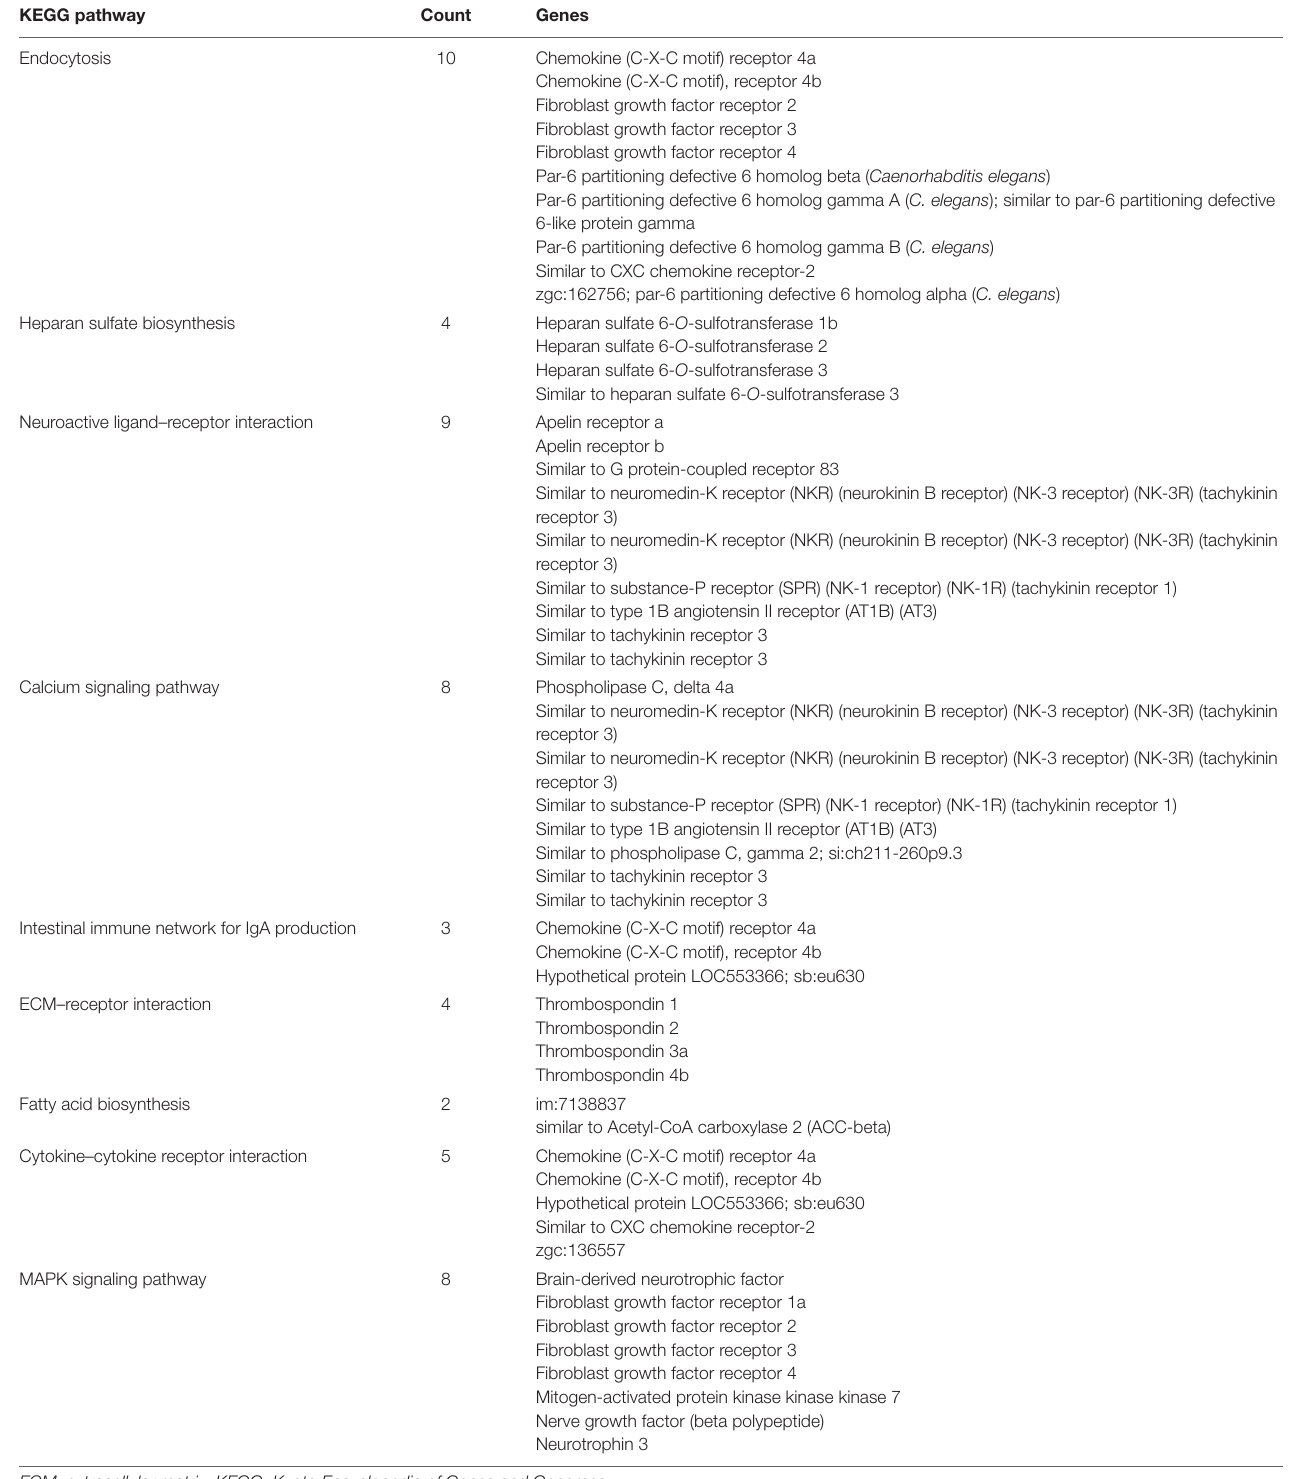
TABLE 3 | KEGG pathways and genes identified using the F ST outlier approach implemented in ARLEQUIN. KEGG